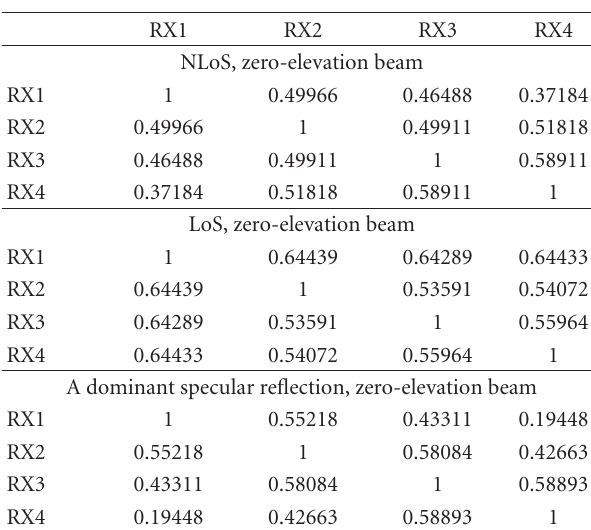
Table 4: Signal envelope correlation of the received